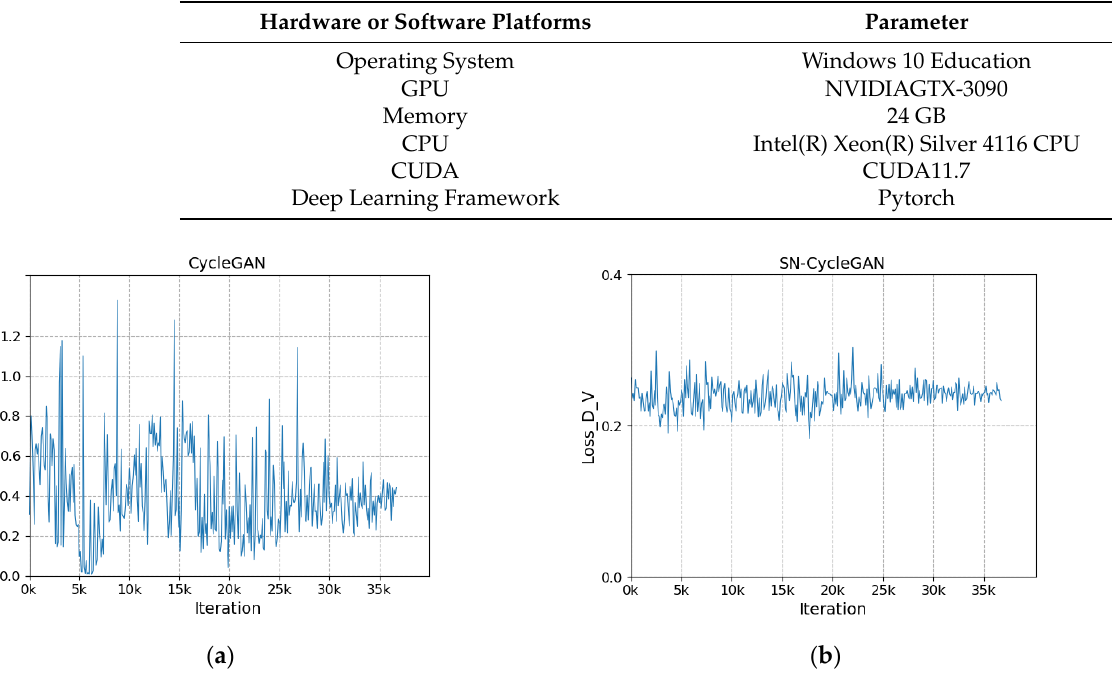
Figure 8. Comparison of discriminator loss for visible light. ( a ) CycleGAN, ( b ) SN-CycleGAN.